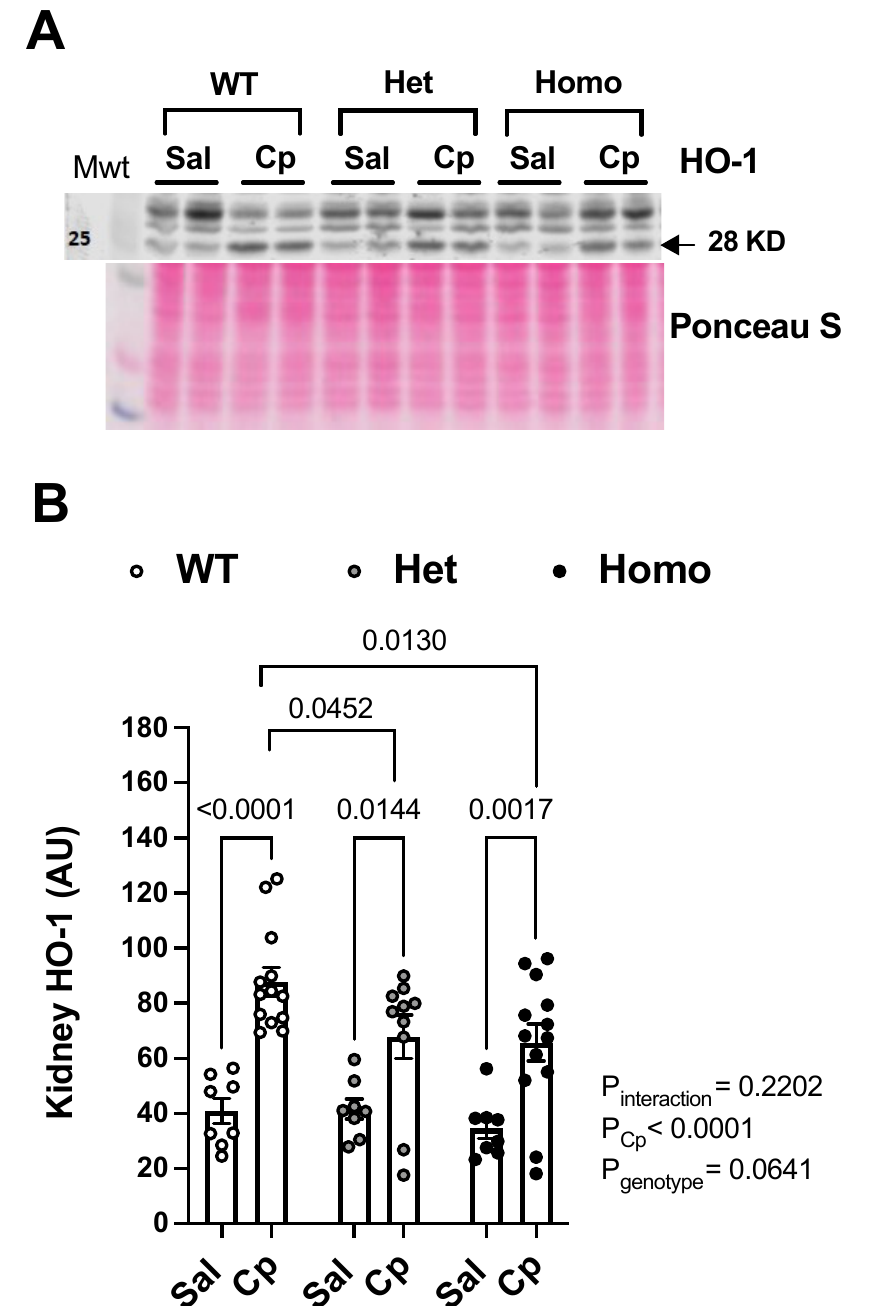
Figure 5. GPER1 deletion blunts cisplatin-induced rise in kidney heme oxygenase-1. Representa- tive images for Western blots on total kidney lysates for heme oxygenase-1 (HO-1, ( A )) measured on day 3 after cisplatin (Cp, 20 mg/kg) or saline injections in male mice, homozygous (homo) and heterozygous (het) knockout for GPER1 gene, and wild-type (WT) littermates. Densitometric values (AU, arbitrary units) for kidney levels of HO-1 ( B ) were normalized to the Ponceau S staining. Data are presented as mean ± SEM (n = 8–13 mice/group). Statistical comparisons were performed by two-way ANOVA with Sidak’s post hoc test for multiple comparisons ( B ). p values for ANOVA and post hoc test results are displayed on the figures. AU, arbitrary units; Cp, cisplatin; Het: heterozygous knockout for GPER1 gene; HO-1, heme oxygenase; Homo, homozygous knockout for GPER1 gene; Sal, saline; WT, wild-type.